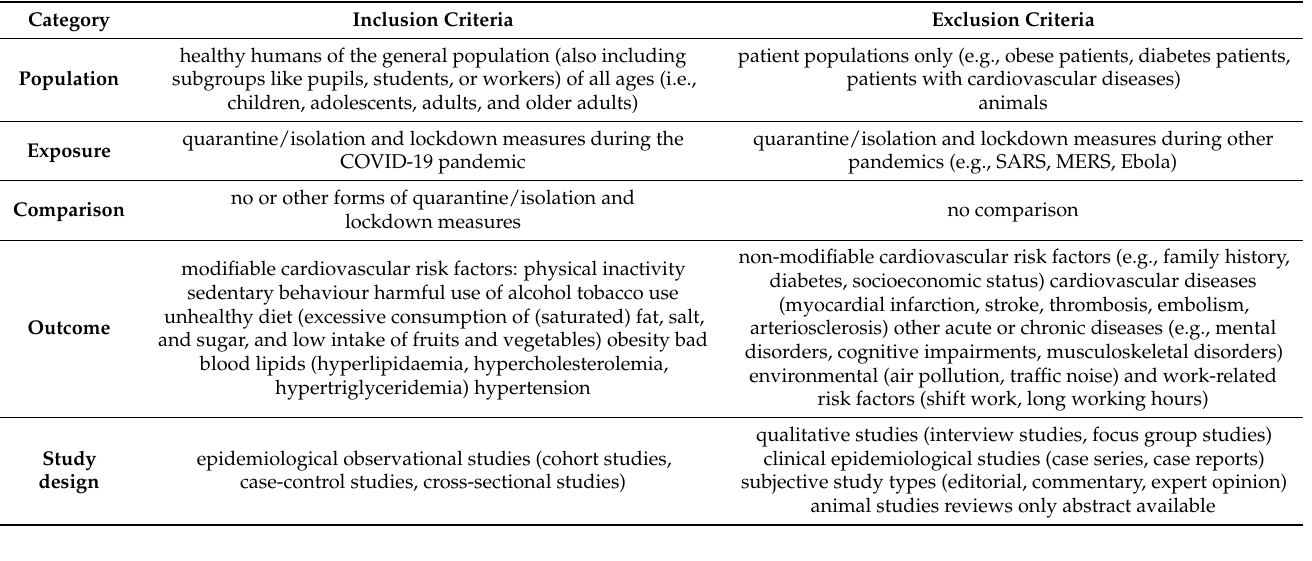
Table 1. Inclusion and exclusion criteria according to the